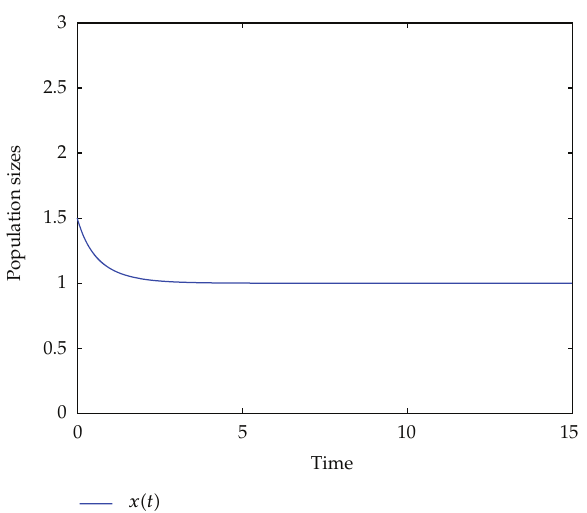
Figure 6: Global asymptotical stability of model (cid:3) 1.1 (cid:4) , step size Δ t (cid:5) 0 . 001 and x (cid:3) 0 (cid:4) (cid:5) 1 .